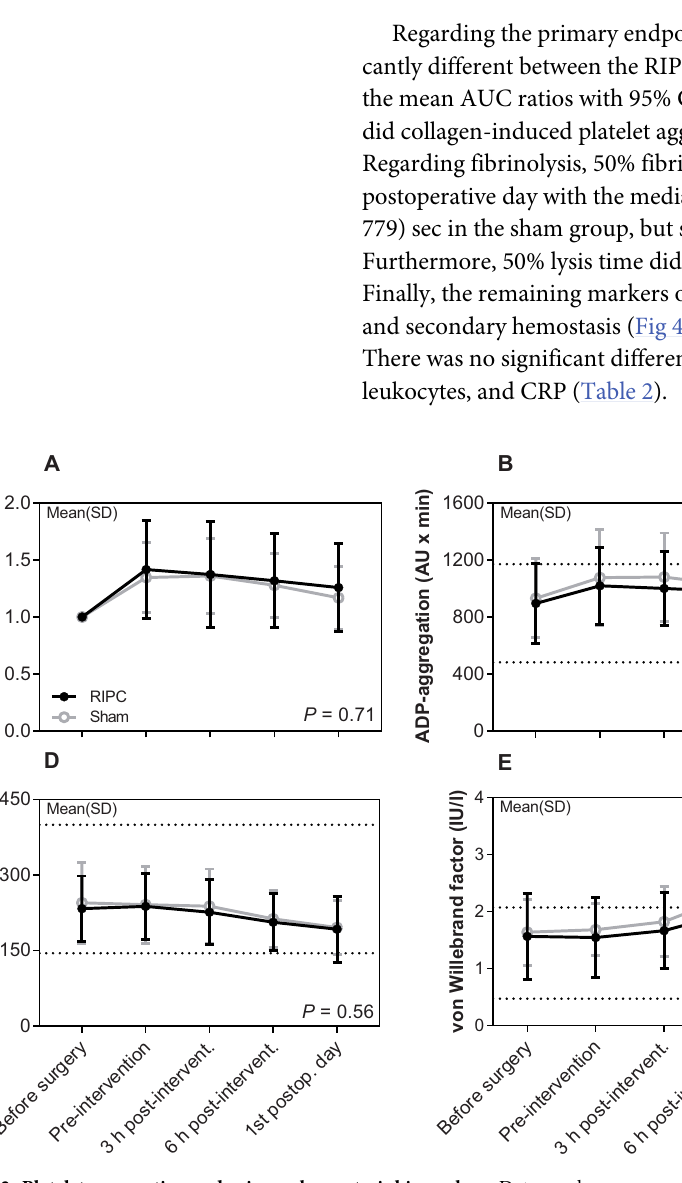
Fig 2. Platelet aggregation and primary hemostasis biomarkers. Data are shown as mean ± SD or median with IQR. Collagen-induced platelet aggregation data are reported as relative changes compared with baseline values because two different collagen reagents were used during the trial. Lines indicate common reference intervals for healthy men and women from our laboratory if available. P -values represent the multivariate repeated measures ANOVA. Abbreviations: COL: collagen, ADP: adenosine diphosphate, RIPC: remote ischemic preconditioning, sP-selectin: soluble P-selectin, TRAP: thrombin receptor activating